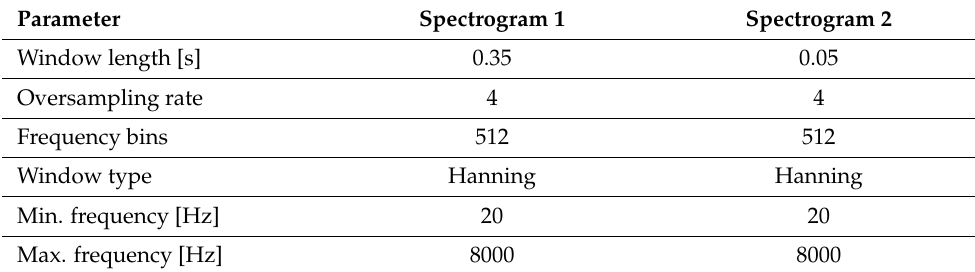
Figure 6. A sample of sound signal with the nominal level of environmental noise (EN) transformed into spectrogram 1 ( a ) and spectrogram 2 ( b ) with pointed HVAC signal components. Table 3. Input parameters for creating both spectrogram types by Gabor